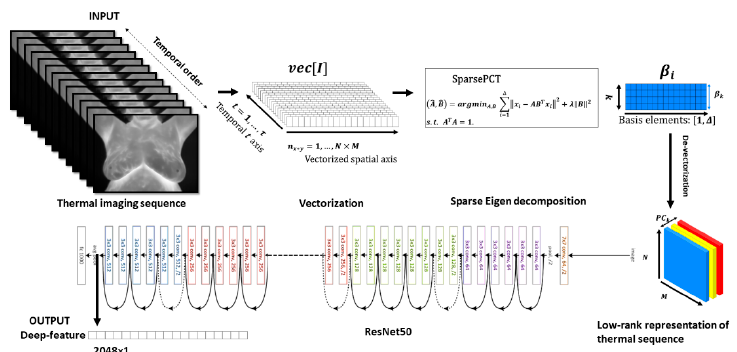
Figure 2. Workflow of the proposed approach in temporal compression and extraction of low-rank matrix approximation and generating the deep thermomics using residual network (ResNet-50) is presented.